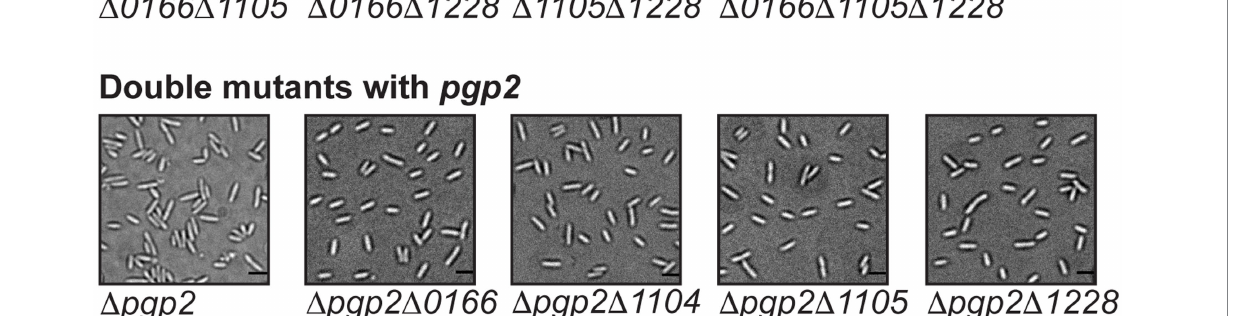
FIGURE 4 Mutant morphology of C. jejuni hydrolase double and triple mutants and double mutants with pgp2 . DIC microscope images of hydrolase double mutants ∆ 0166 , ∆ 1105 , ∆ 0166 , ∆ 1228 , and ∆ 1105 , ∆ 1228 and the triple mutant ∆ 0166 , ∆ 1105 , ∆ 1228 , as well as double mutants with pgp2 , including images of the wild-type 81-176 strain and the single mutants for comparison. The scale bar indicates 2 μ